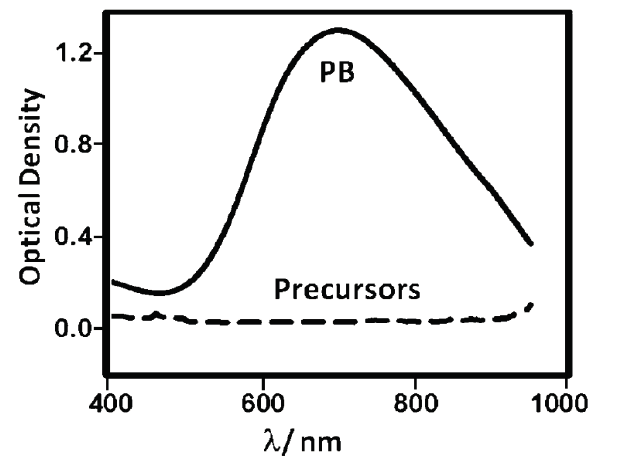
Figure 2. UV-vis spectra of the PBNP dispersion and its